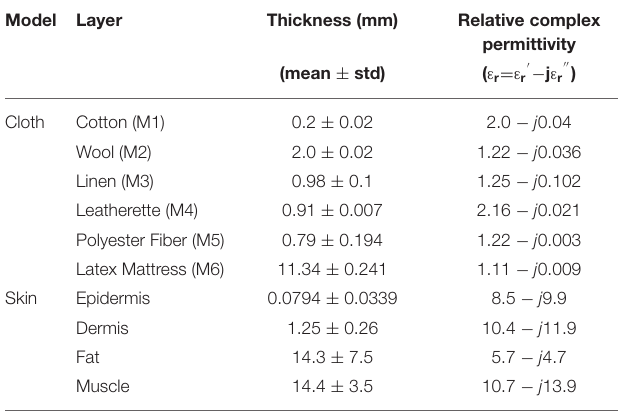
TABLE 1 | Dielectric constants and thickness of cloth materials and skin tissues (mean ± standard deviation) used in Monte Carlo simulation. Model Layer Thickness (mm) Relative complex permittivity (mean ±